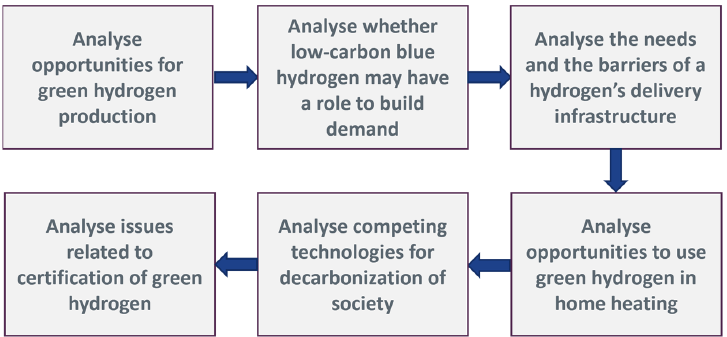
Figure 2. Methodology for assessing the potential for transition towards a low-carbon hydrogen society. Table 1. Stakeholders involved in the call for evidence.